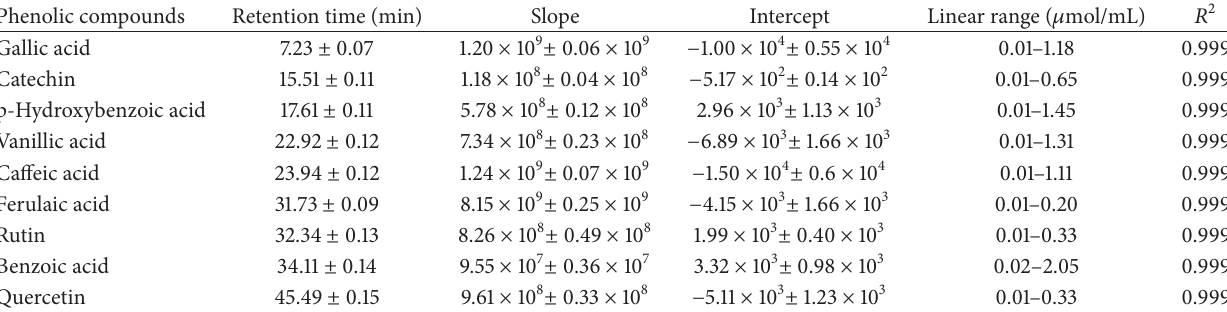
Table 3: Summary of HPLC method performance: linear equation, linear ranges, and coefficients of phenolic compounds ( 𝑛 =